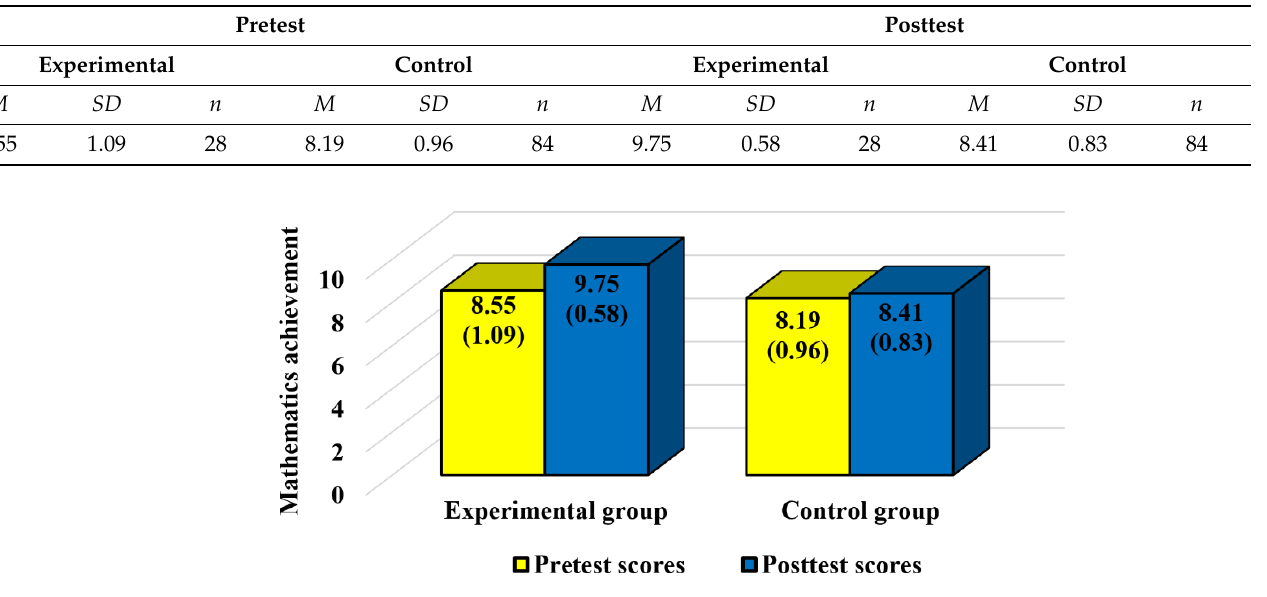
Figure 3. Experimental group and control group pretest and posttest scores and standard deviations.